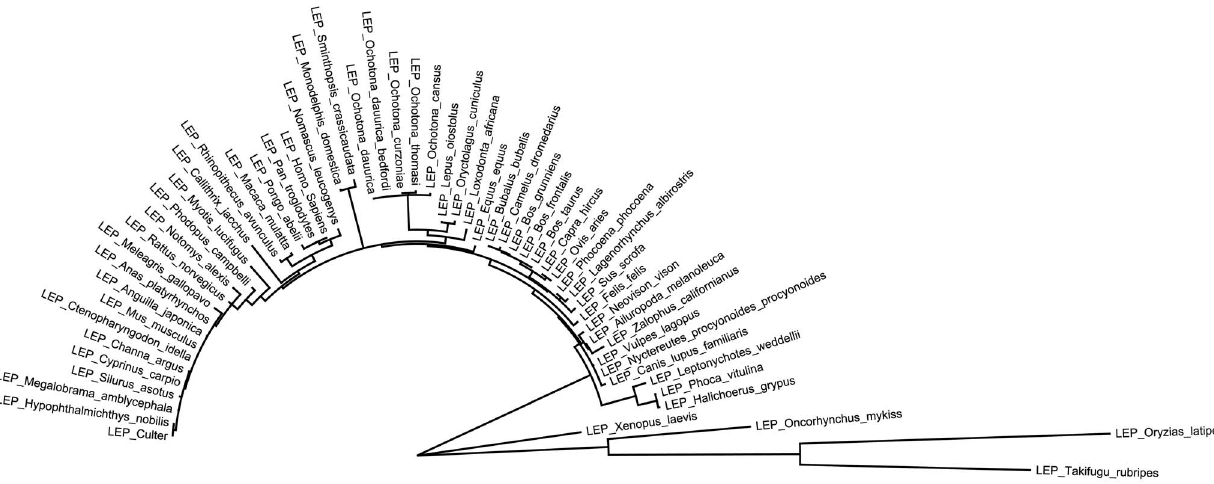
Figure 5. Protein sequence relationship between derived African elephant leptin protein and other members of cyclical cytokine family. The class I helical cytokine superfamily has been described earlier. The sequence relationship between the derived elephant leptin protein sequence and other members of cyclical cytokine family was therefore analyzed. An alignment of class I helical cytokine family members was prepared using MUSCLE and phyml used to generate a tree using the WAG model and 100 replicates were used to generate bootstrap values. These were then combined into a single tree by hand and colored by cytokine sub-family. The relationship of the African elephant leptin protein was determined relative to the sequence in other mammalian species, to contextualize the relationship of elephant leptin structure to that of leptin in other species. The global tree is available as a supplemental figure (Figure S2).